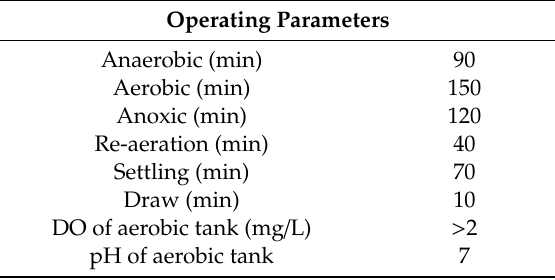
Figure 1. ( a ) A 2 O mold schematic and ( b ) batch experiment reaction tank. Table 1. National Chi Nan University (NCNU) wastewater treatment plant operating